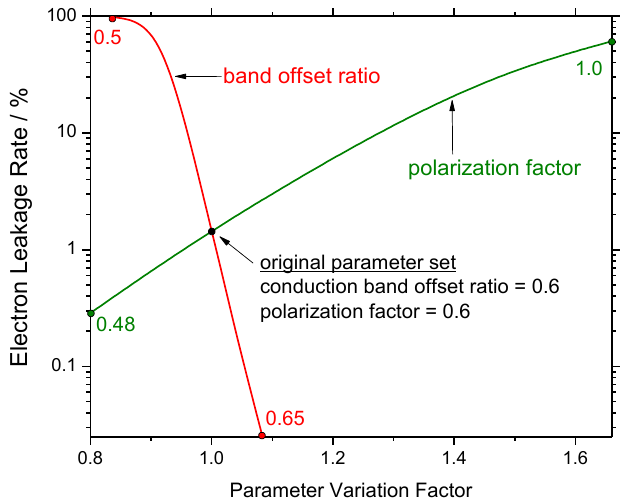
Figure 5. The calculated electron leakage is extremely sensitive to variations of the conduction band offset ratio ΔE c /ΔE g (cf. Figure 2) and the scaling factor applied to the theoretically predicted material polarization field of the electron blocker layer [38].